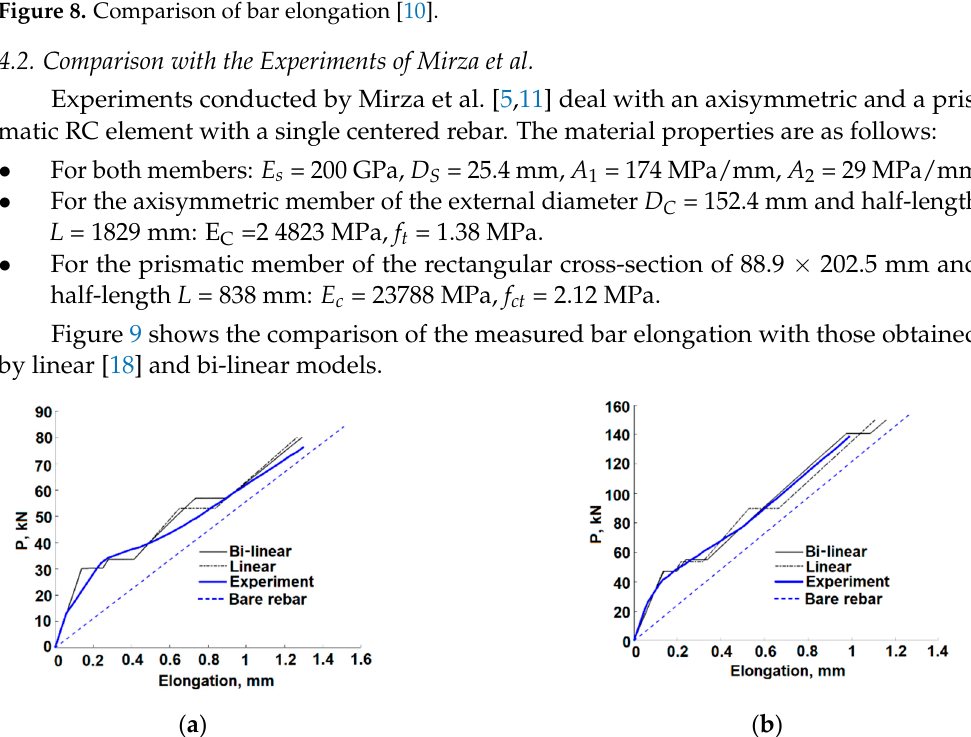
Figure 8. Comparison of bar elongation [10].